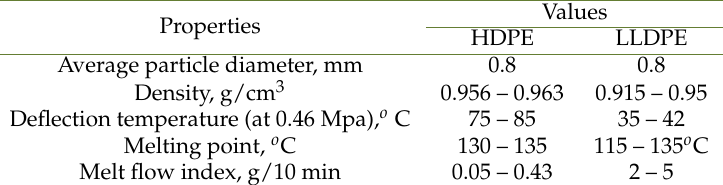
Table 1. Polymers HDPE and LLDPE physical properties